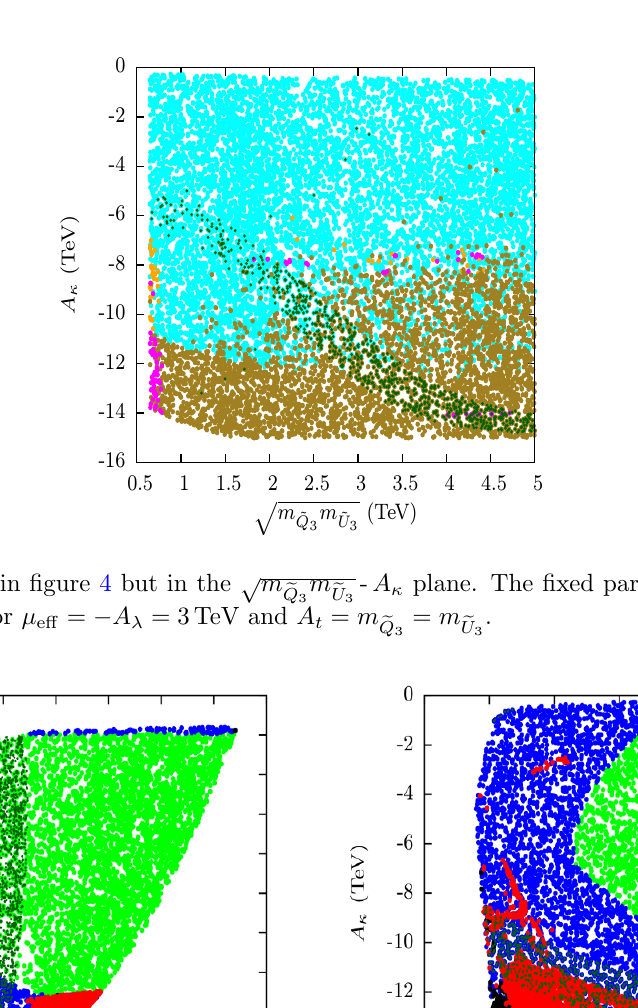
Figure 7 . Scatter plots showing the stability status of the DSB vacuum in the A (cid:21) - A (cid:20) plane in the presence of a deeper CB minimum. Color code in use are as adopted for (cid:12)gure 2. The left (right) plot corresponds to the same set of data points as used in the left plot of (cid:12)gure 4 (right plot of (cid:12)gure